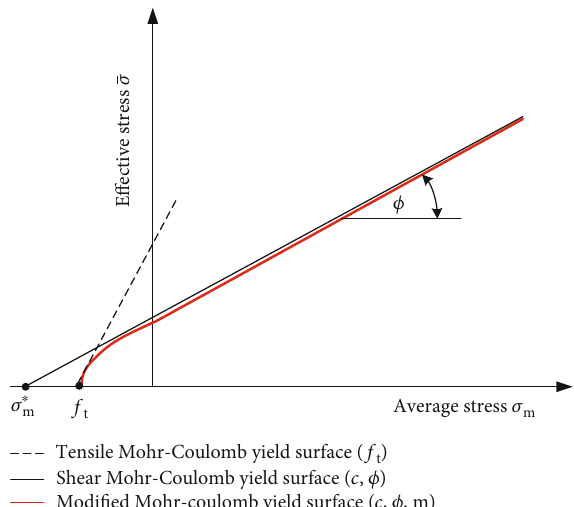
Figure 1: Modi fi ed Mohr-Coulomb criterion in the meridional plane.